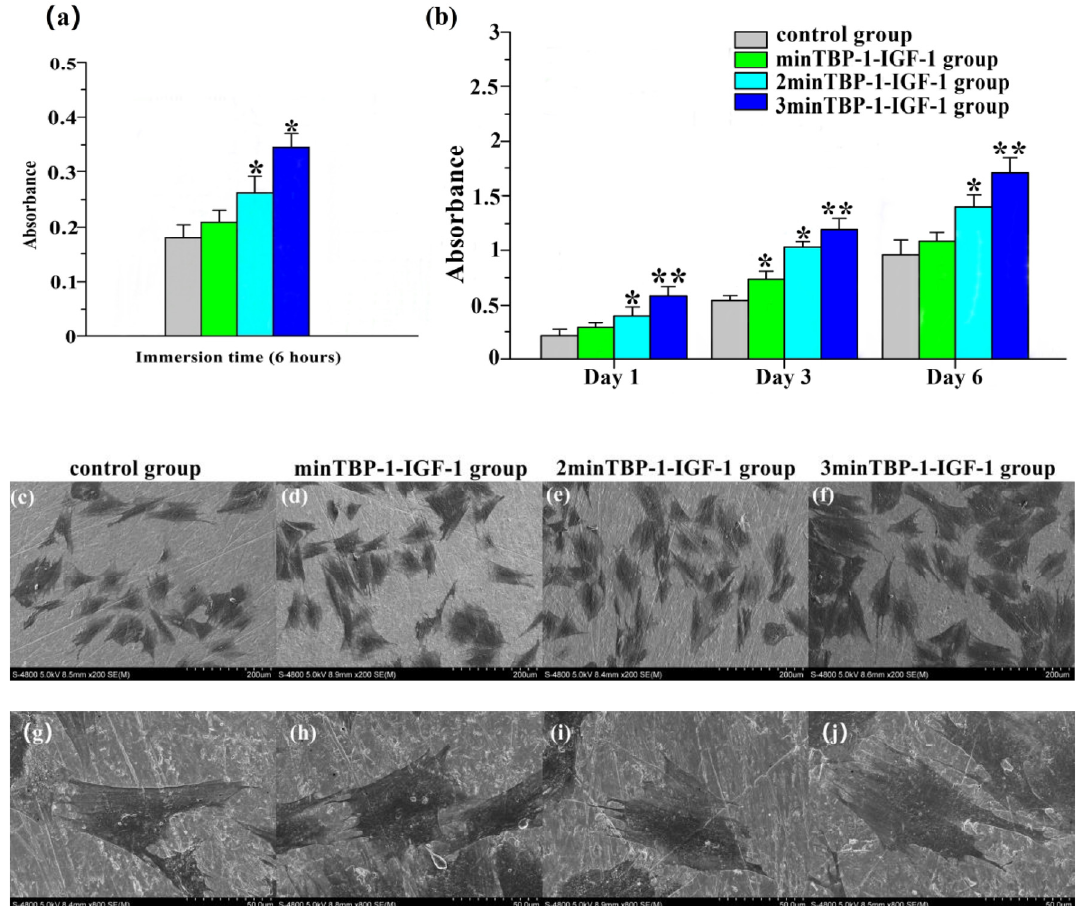
Figure 3. ( a ) Absorbance of osteoblast attachment by CCK-8 assay after 6 h of incubation. ( b ) Absorbance of osteoblast proliferation by CCK-8 after culturing for 1, 3, and 6 days on machined Ti and the (n)minTBP-1-IGF-1 interfaces. ( c – f ) SEM images of osteoblasts after culturing for 7 days on different samples at lower magnification (×200). ( g – j ) SEM images of osteoblasts after culturing for 7 days on different samples at higher magnification (×800). n = 10, * p < 0.05, ** p < 0.01.